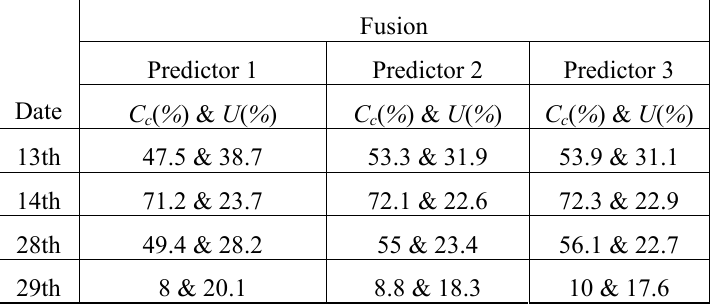
) and unknown rate ( U ) for individual sensors c